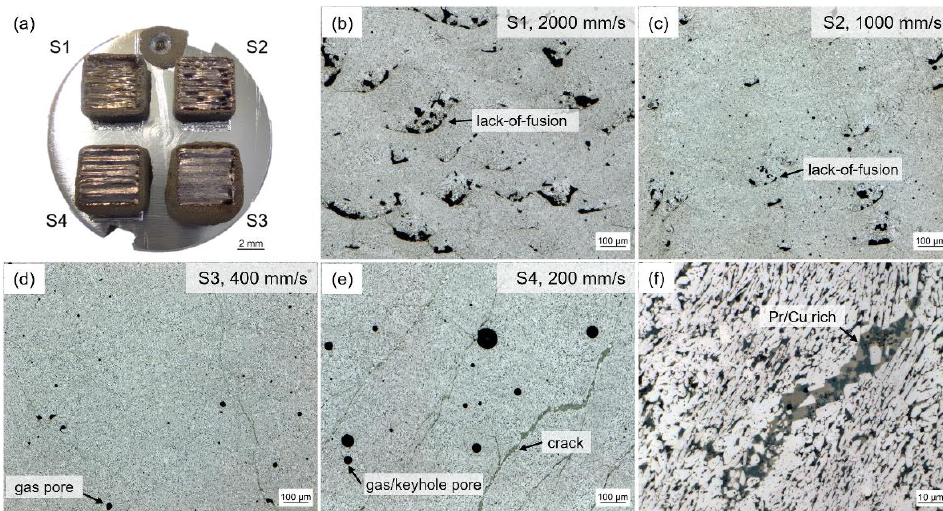
Figure 2. Printed parts of the Fe73.8-Pr20.5-Cu2.0-B3.7 powder. ( a ) Macrograph of four different laser scanning speeds (S1: 2000 mm/s (VED: 21.7 J/mm 3 ), S2: 1000 mm/s (43.5 J/mm 3 ), S3: 400 mm/s (108.7 J/mm 3 ), S4: 200 mm/s (217.4 J/mm 3 )) in top view. ( b – e ) Optical microscopy images of corresponding microstructures of the four samples S1 ( b ), S2 ( c ), S3 ( d ) and S4 ( e ). ( f ) Pronounced crack in sample S4 filled with eutectic phase. Relative densities of the samples are for S1: 93%, S2: 94%, S3: 97% and S4: 93%.